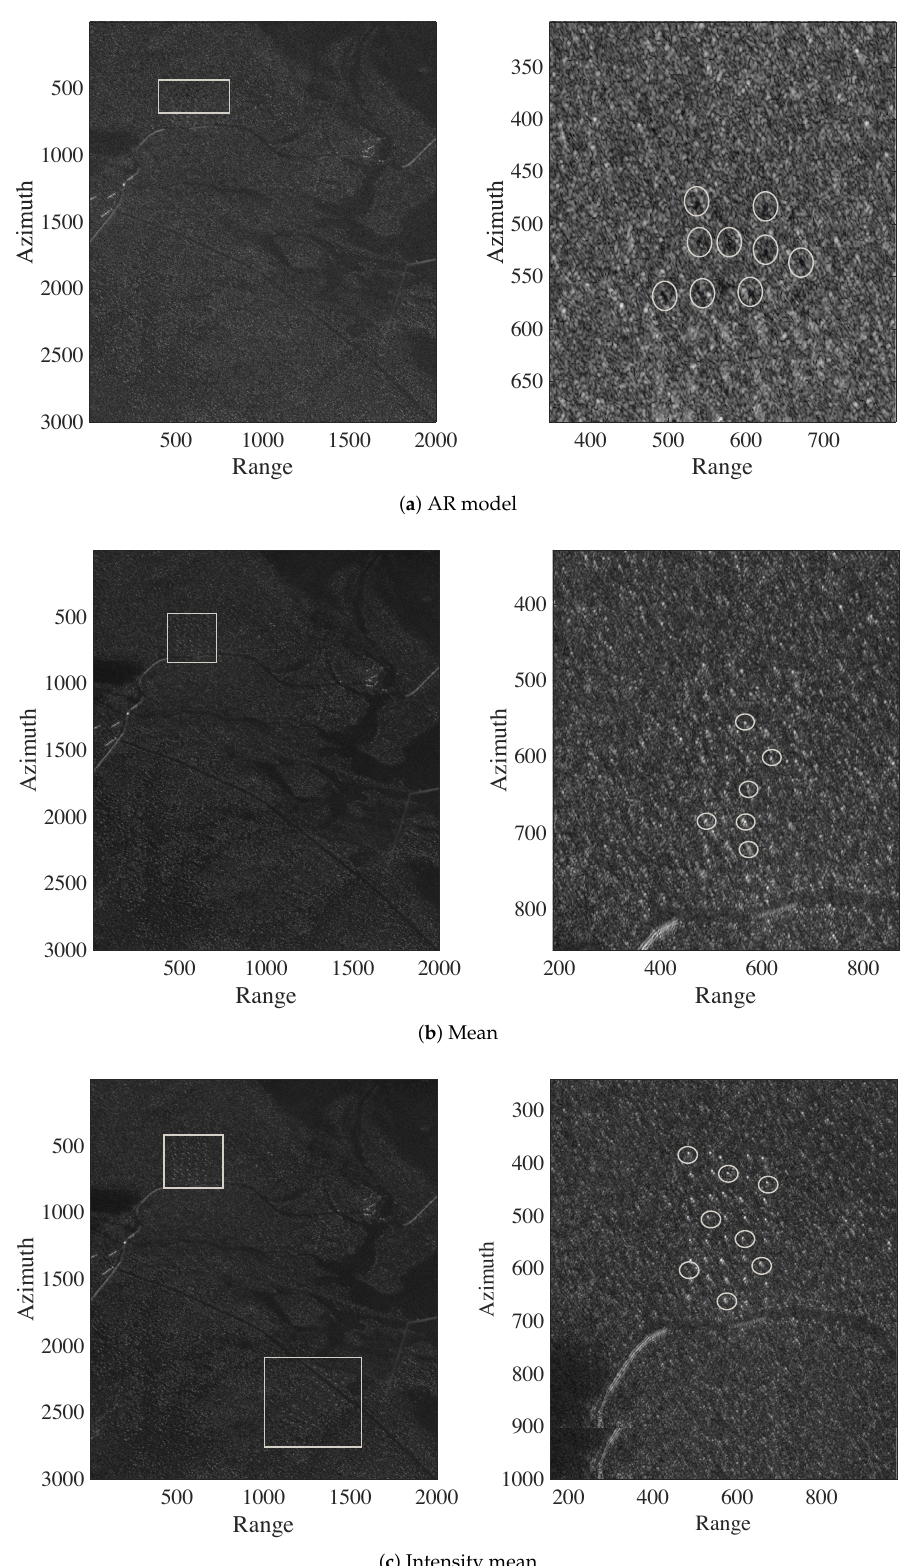
Figure 4. Ground scene prediction images for Stack 1 based on the autoregressive (AR) model, mean, and intensity mean methods. The areas highlighted by rectangles in the images represent the regions where the targets are deployed. The circles show selected military vehicles that can be